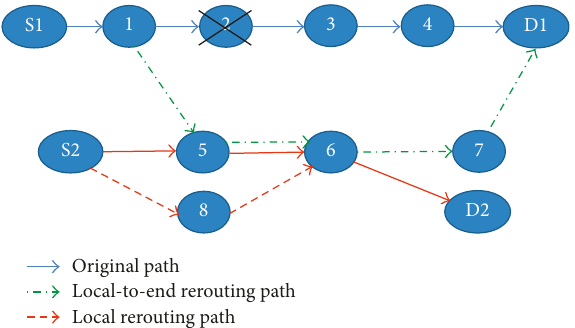
Figure 6: Solution approach for node failure recovery in WSN